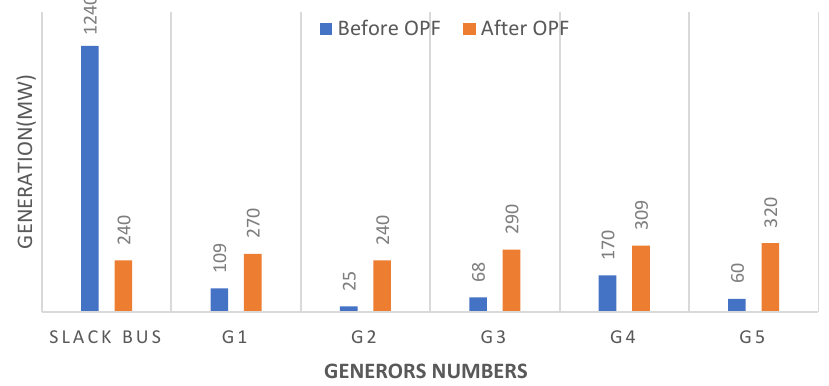
Figure 3. Distribution generation among different buses before and after the OPF .